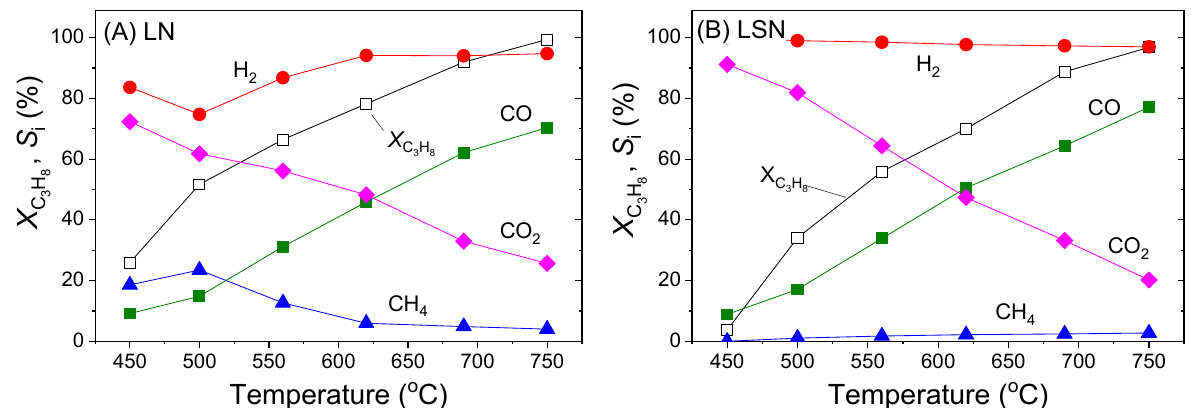
Figure 3. Conversion of propane (XC 3 H 8 ) and selectivities to the indicated reaction products obtained over ( A ) the LaNiO 3 (LN) and ( B ) the La 0.8 Sr 0.2 NiO 3 (LSN) samples. Experimental conditions: mass of catalyst: 100 mg; particle diameter: 0.18 < d < 0.25 mm; feed composition: 2.3% C 3 H 8 , 22.9% H 2 O, 0.7% Ar (balance He); total flow rate: 200 cm 3 min − 1 .